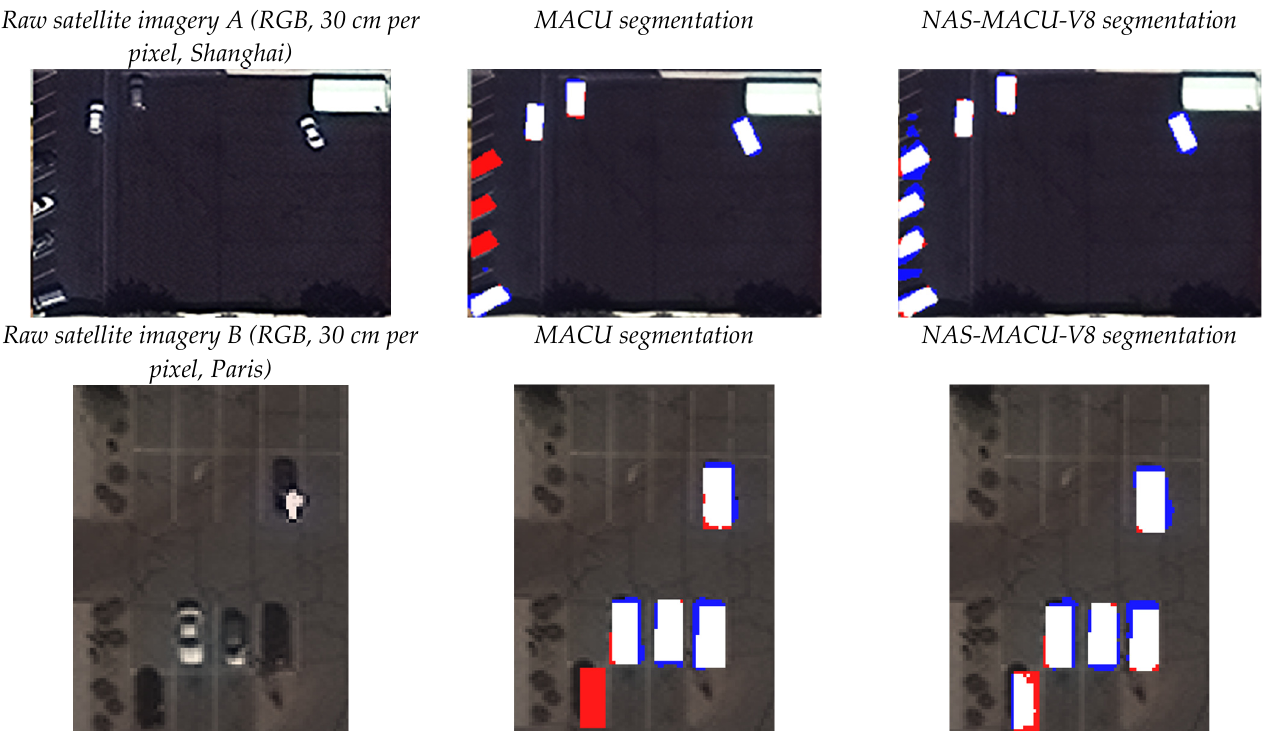
Figure 12. Visual representation of segmentation obtained by MACU and NAS-MACU-V8. Blue color represents the ‘light-vehicle’ object class recognized by MACU or NAS-MACU-V8, red color represents the polygons marked by the annotator (ground truth), white color represents an accurate per-pixel prediction result.